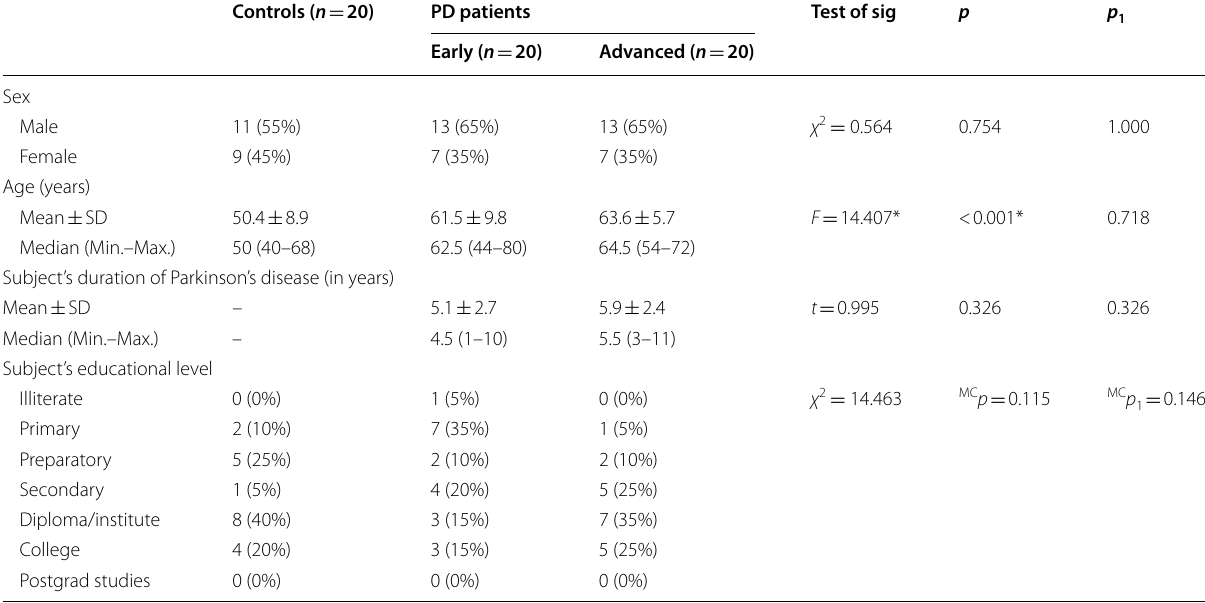
Table 2 Comparison between the studied groups according to demographic